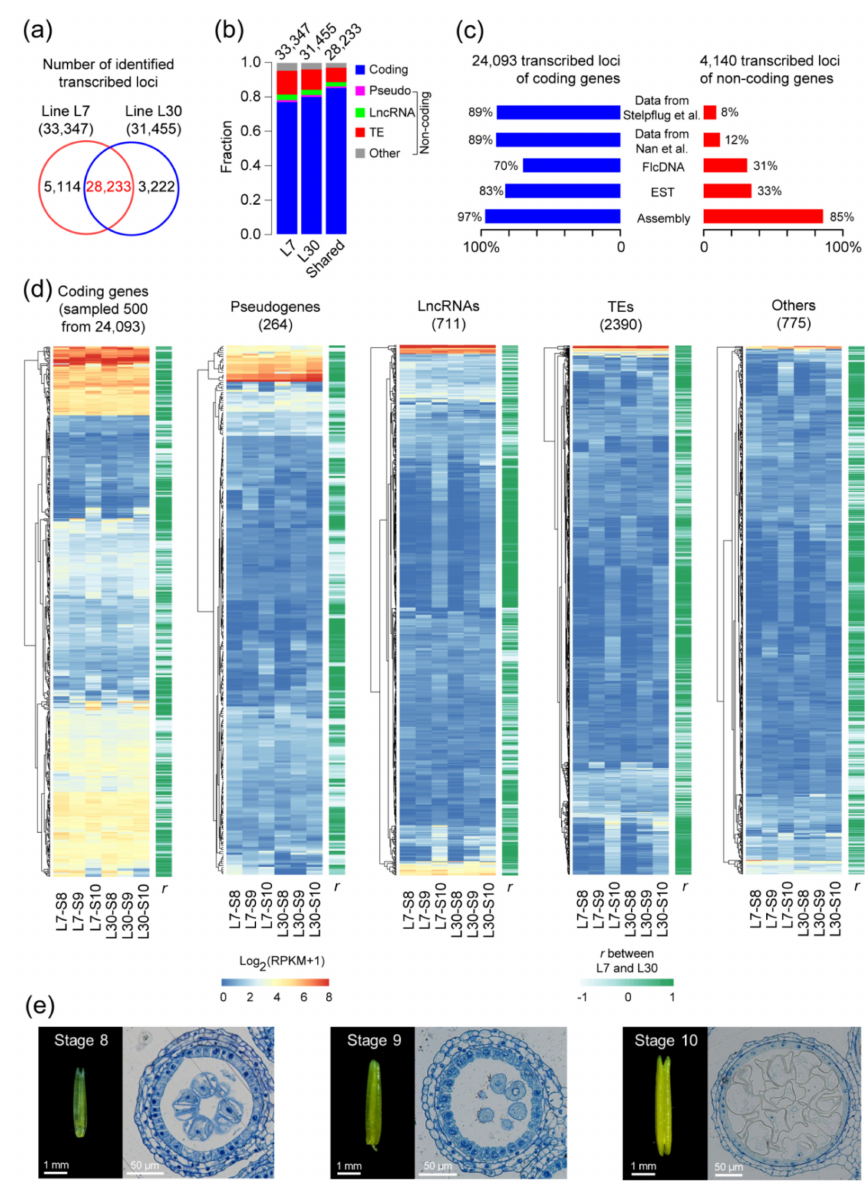
Figure1. Identificationandclassificationoftranscribedlociinthedevelopingmaizeanther. ( a )Numbers of transcribed loci identified in transcriptomes of the two maize lines. Only the 28,233 loci that overlapped between the two lines (marked in red) were used in this study. ( b ) Classification of the transcribed loci into five types. “Coding” represents coding genes, and “Pseudo” represents pseudogenes. ( c ) Confirmation of the coding and non-coding transcribed loci by using the published data and the public databases. Maize anther transcriptome datasets from two previously-published studies were reanalyzed here [36,37]. ( d ) Transcription expression patterns of transcribed loci used in this study. Anther developmental stages 8, 9, and 10 are represented by S8, S9, and S10, respectively. Transformed transcription levels > 8 were designated as 8 to facilitate the comparisons of transcription expression patterns among the five types of transcribed loci. Correlation of the transcription expression levels between maize lines L7 and L30 at the three stages for each transcribed locus was estimated using Pearson’s correlation coe ffi cient ( r ). ( e ) Anther phenotypes (left) and transverse section analysis (right). We sequenced transcriptomes from maize anther at developmental stages of S8, S9, and S10, respectively. The developmental stages of anther samples were identified by transverse section